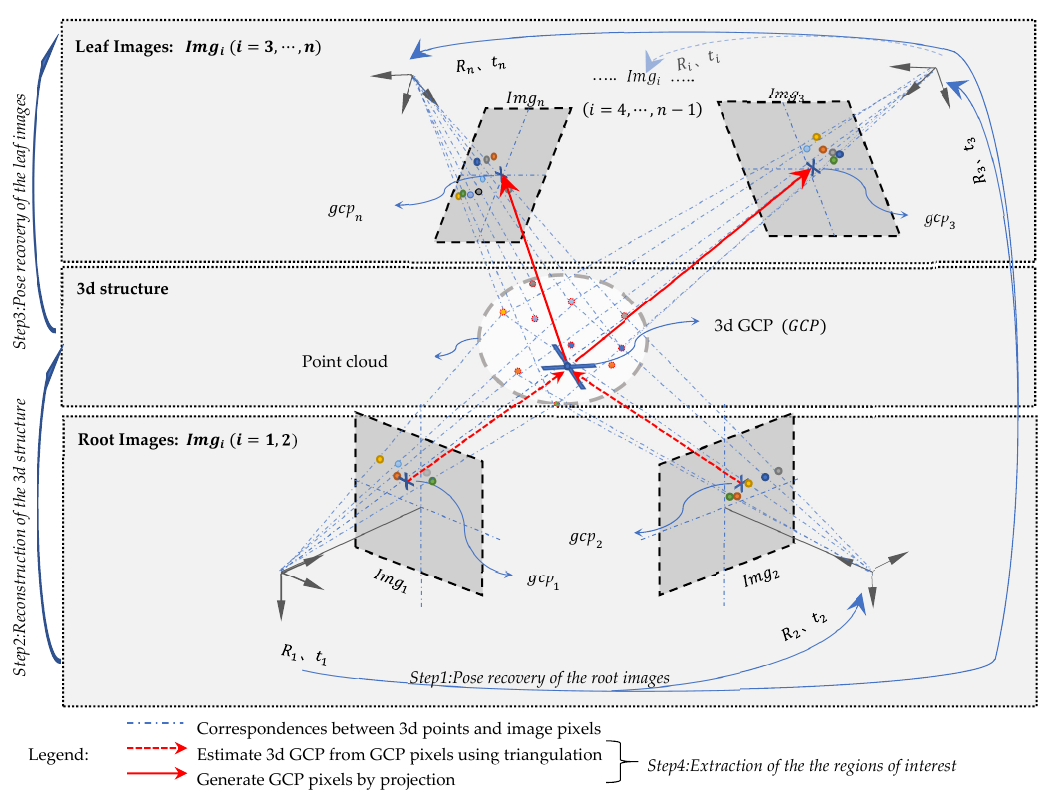
Figure 2. Schematic diagram of extracting the ROIs from drone images using multi-view constraints.